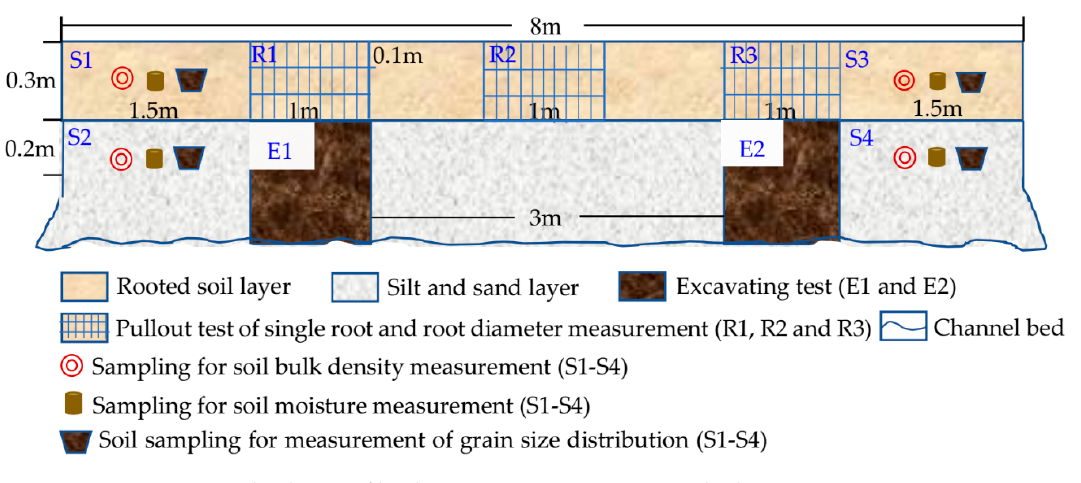
Figure 3. The design of bank excavation experiments and other measurements.